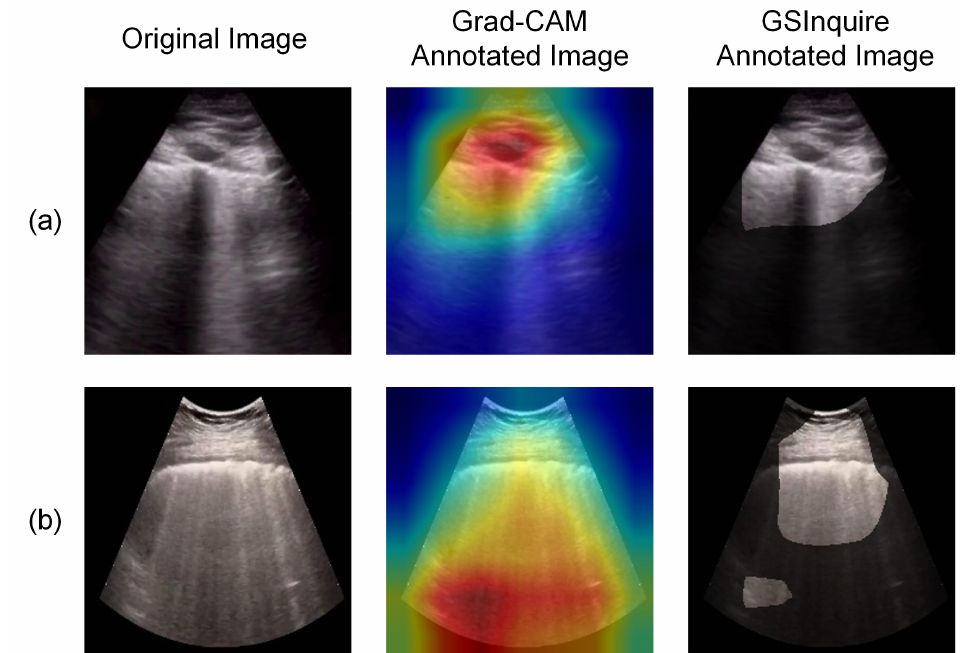
Figure 4. COVID-19 positive case examples correctly classified by COVID-Net USPro with high confidence: ( a ) an example of wrong decision factors. ( b ) an example of a decision made based on disease-related